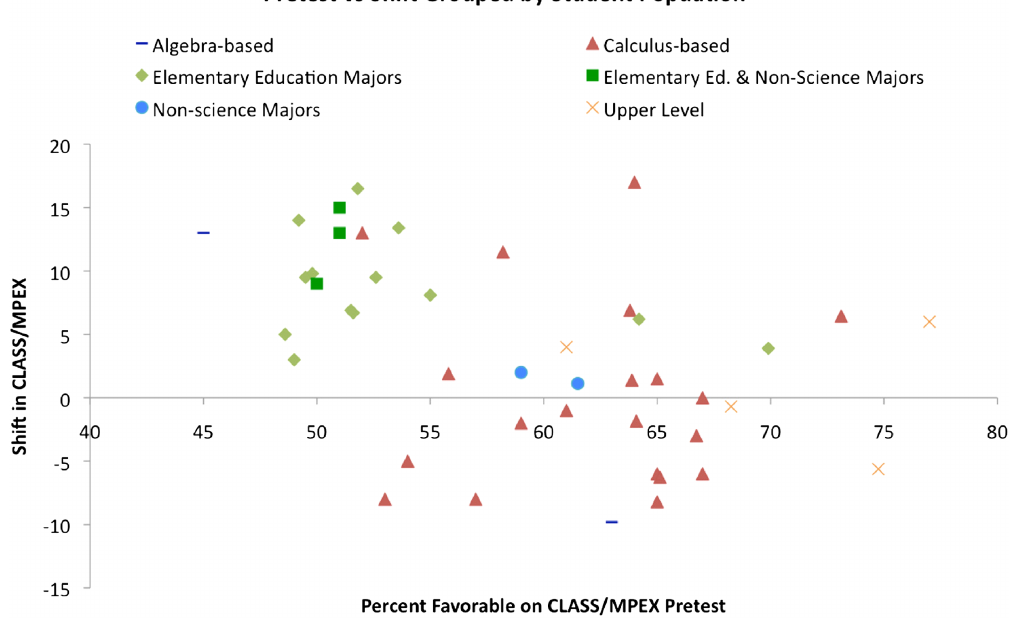
FIG. 6. Pretest percent expertlike scores versus shifts on CLASS and MPEX with data points grouped by student